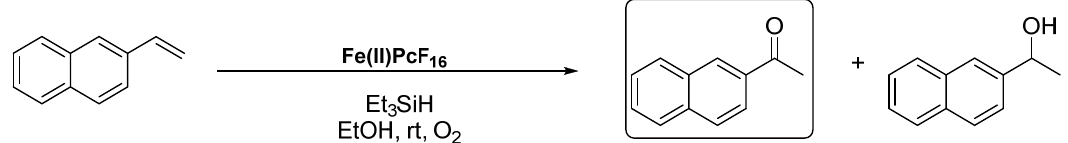
Figure 34. Fe(II) complex of the hexadecafluorinated phthalocyanine (Fe(II)PcF 16 ) used as catalyst in the oxidation of 2-vinylnaphthalene as model substrate (adapted from [83]).